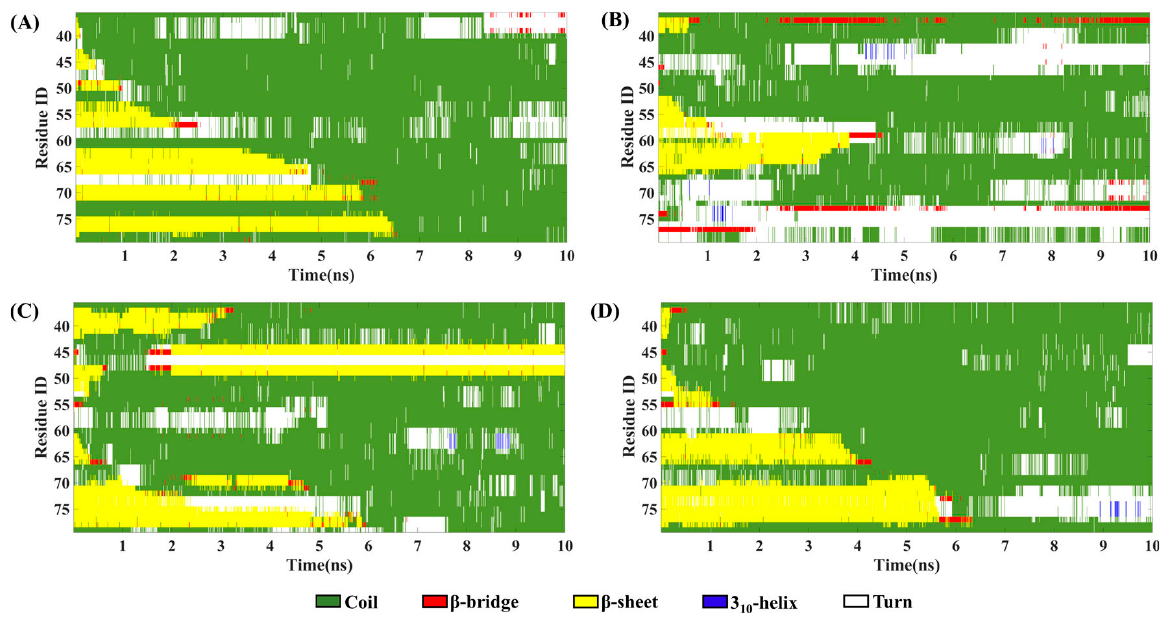
Table 1. Dissociation path statistics of the boundary chains of the three systems.